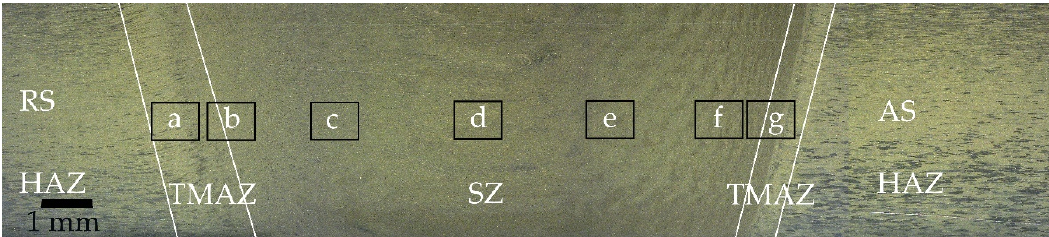
Figure 3. The macrostructure of the joint, showing different regions separated by white lines; the rectangles show EBSD acquisition spots.